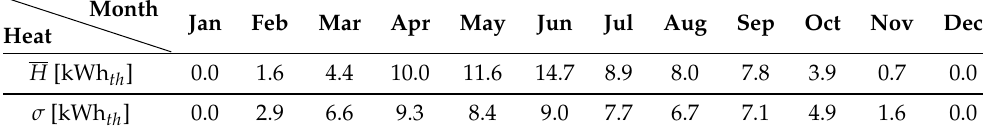
Table 1. Monthly average collection of solar heat.